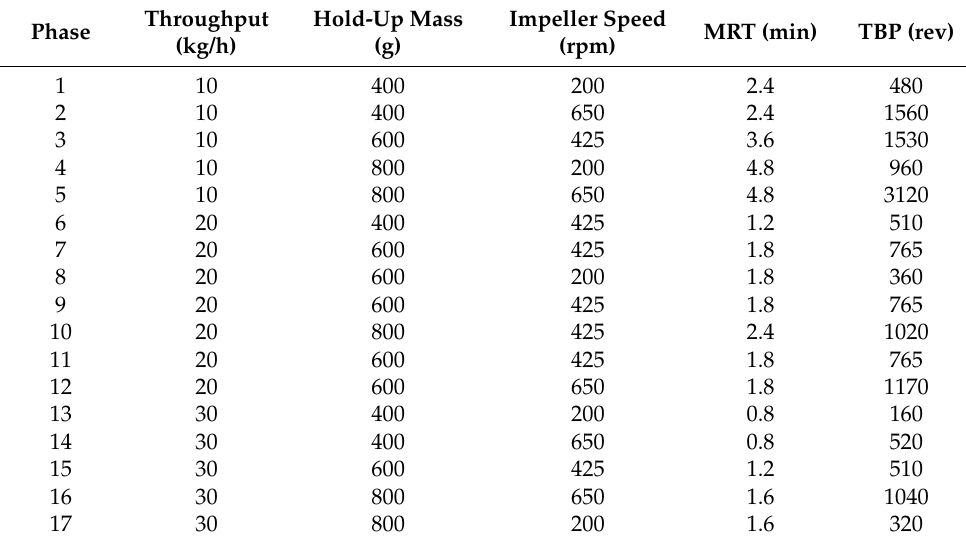
Table 2. DoE settings, where phase 7, 9 and 11 are the replicates of the center point.